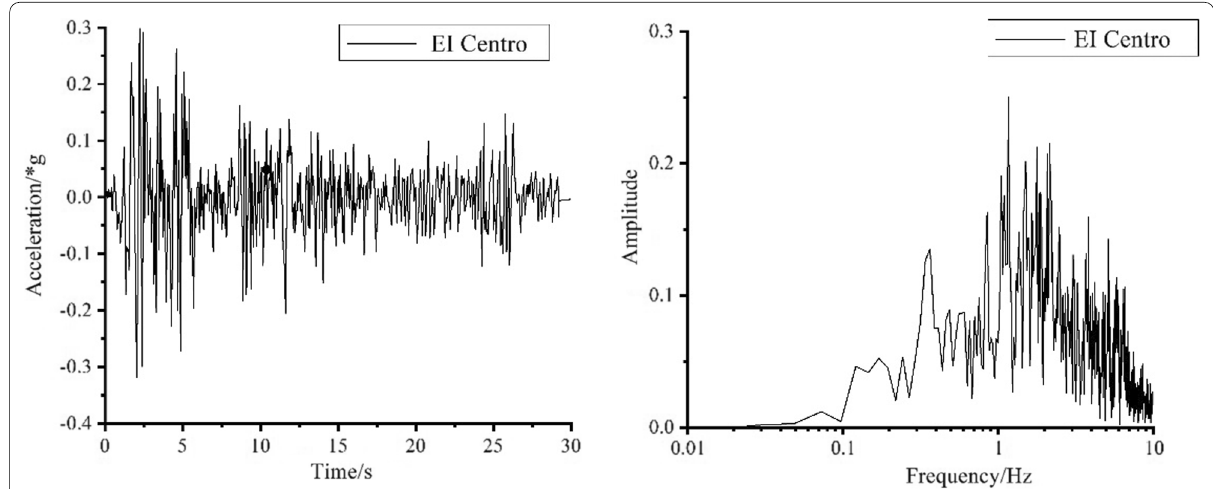
Fig. 2 Time history curve and Fourier spectrum of El Centro ground motion